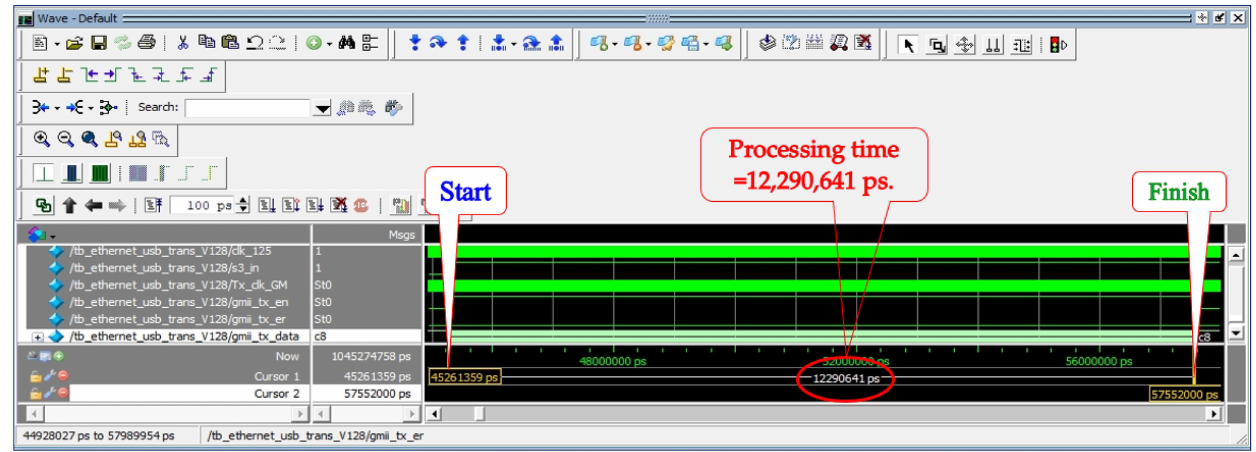
Figure 21. The processing time required to transmit the largest Modbus/TCP payload of 1460 bytes at the processing clock frequency of 125 MHz.